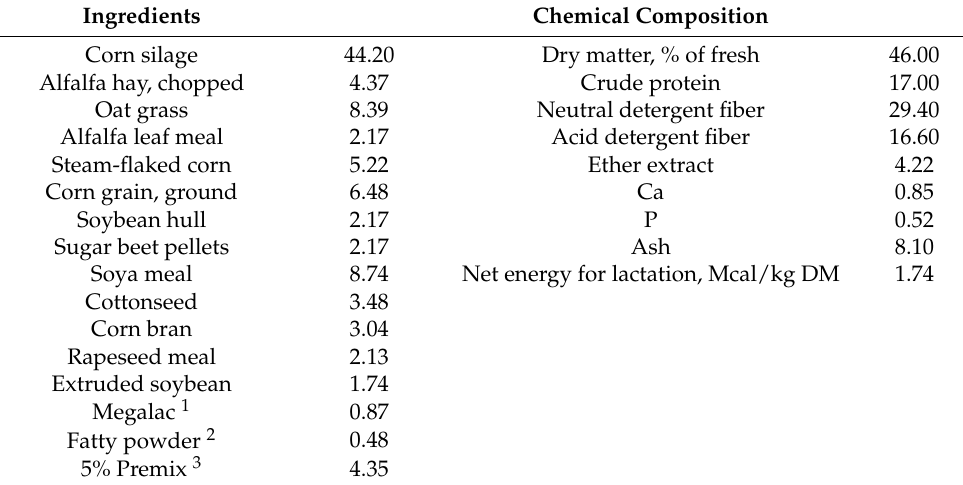
Table 1. Ingredients and chemical composition of basal diet (% of DM, unless otherwise